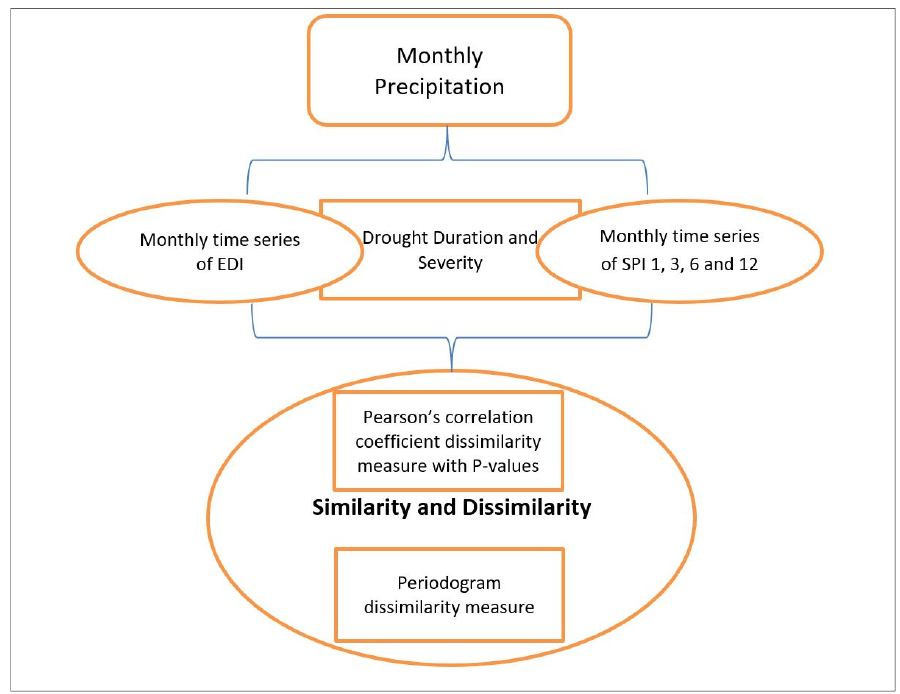
Figure 2. Methodological flowchart of assessment of the dissimilarities of EDI and SPI measures for drought determina- tion.